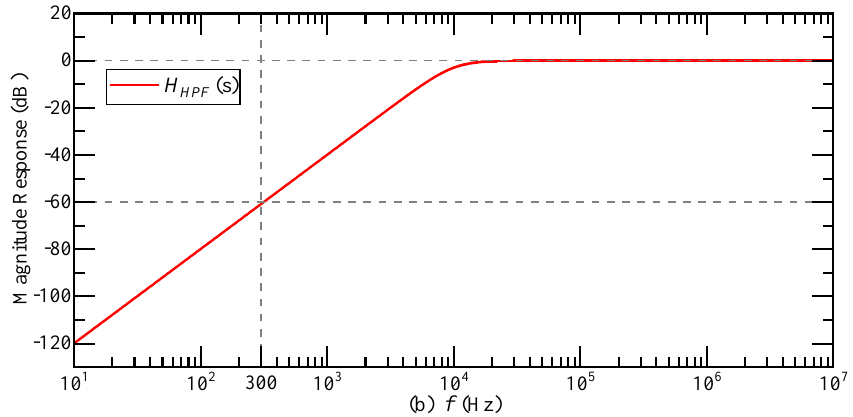
Figure 15. ( a ) High-pass filter structure; ( b ) Amplitude-frequency characteristic curve of high-pass filter.